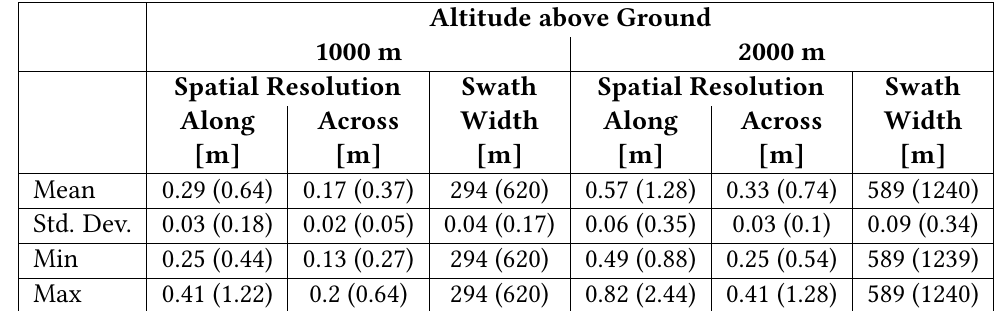
Table 1: Selection of geometric parameters for the HySpex VNIR 1600 at two typical flight altitudes. Values in brackets are obtained with FOV expander lens